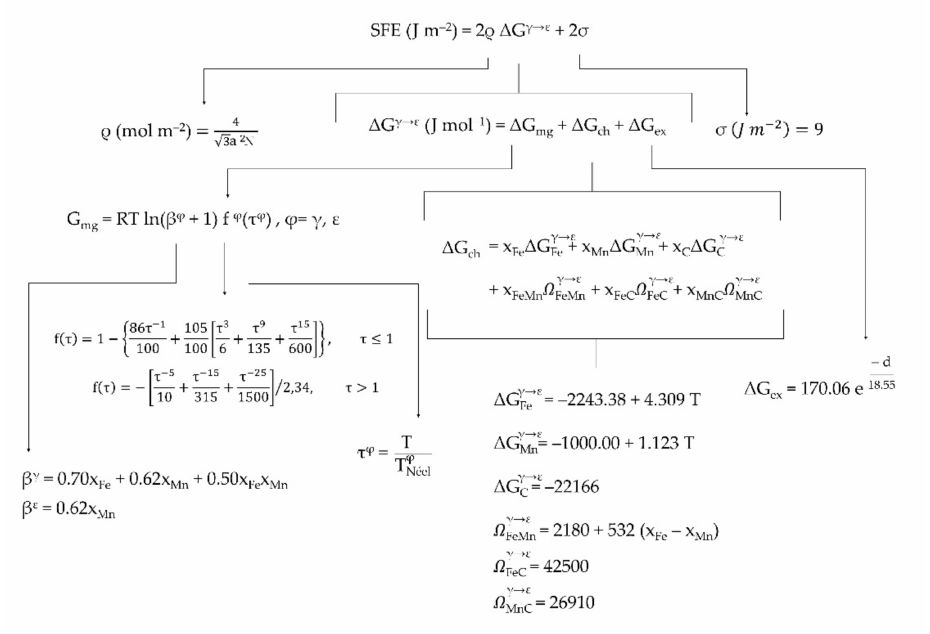
Figure 1. Breakdown of the modified thermodynamic model and numeric values used in this